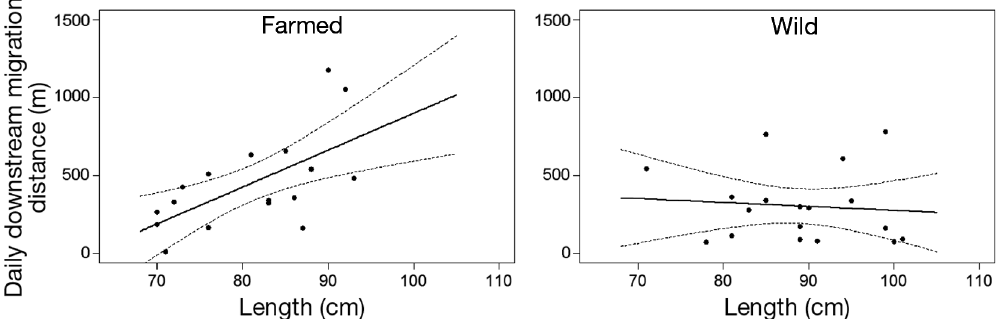
Fig. 7. Predicted (solid line) daily downstream movement distance of Atlantic salmon Salmo salar plotted as a function of body length and origin, showing upper and lower 95% CI (dotted lines). Dots: observed values. The predictions were retrieved from the linear model provided in Table 1. N = 18 wild and 17 farmed Atlantic